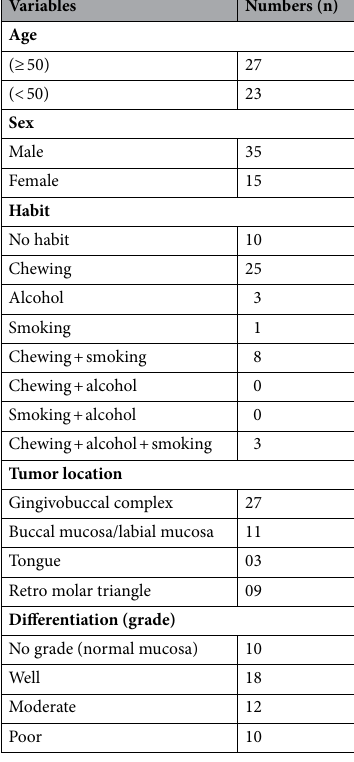
Table 2. Clinical and demographic characteristics of the samples in OSCC for POSTN, TNC and CAV1 for Immunohistochemistry